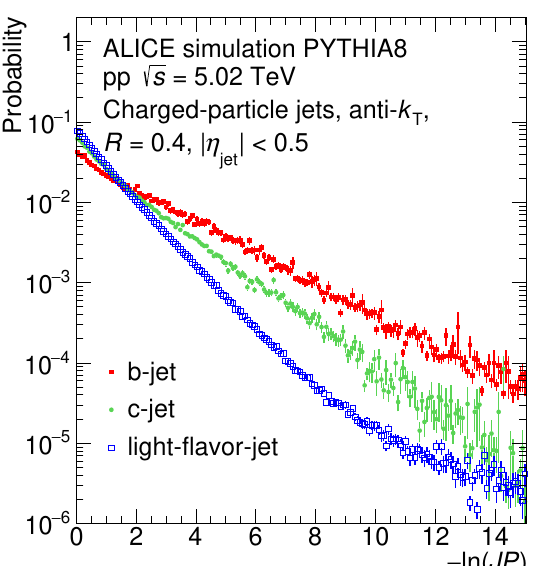
Figure 2. The logarithmic jet probability − ln( JP ) distribution for light-flavor, charm, and beauty √ jets in pp collisions at s = 5 . 02